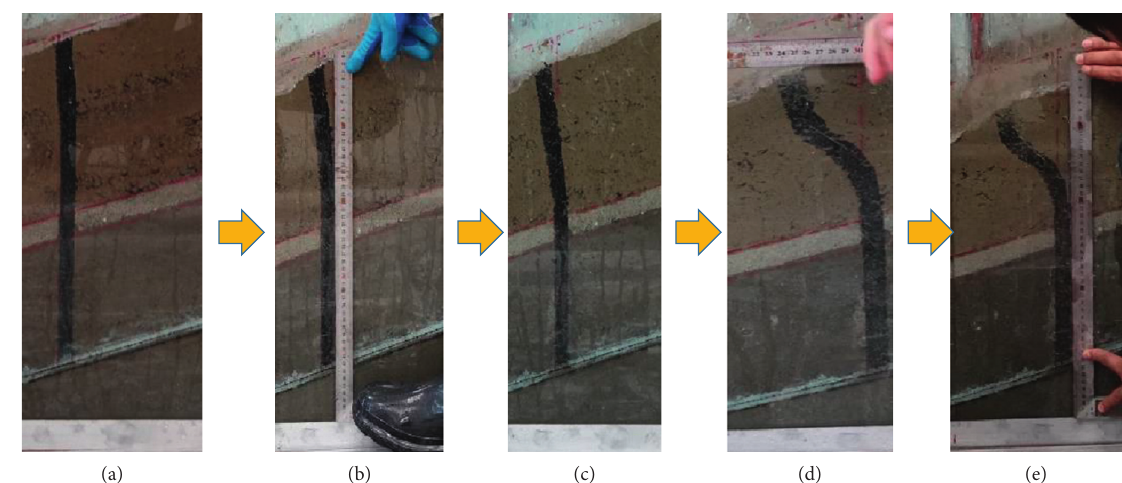
Figure 11: Horizontal displacement change of vertical section of slope toe. (a) 15: 41. (b) 16 :18. (c) 17 :13. (d) 17: 54. (e)